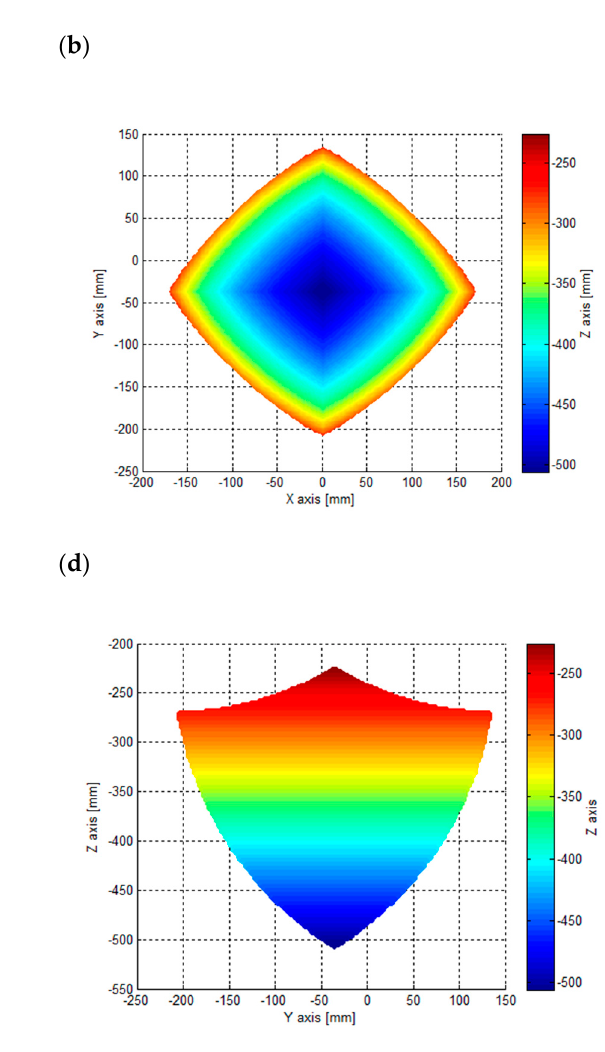
Figure 8. Manipulator operating space: ( a ) general overview, ( b ) view in XY plane, ( c ) view in XZ plane, ( d ) view in YZ plane.